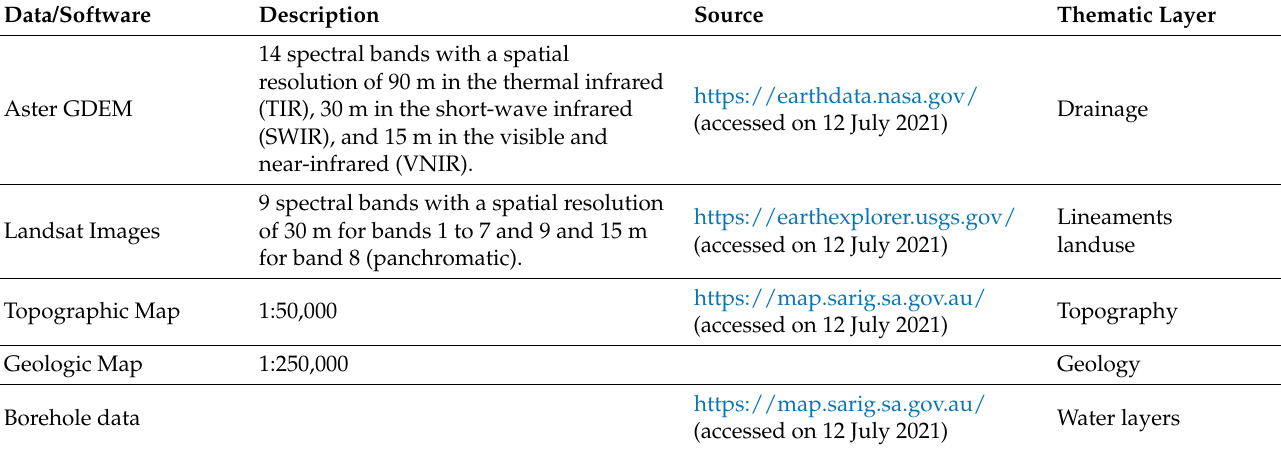
Table 1. Data and sources used for GWRP analysis for the Hawker